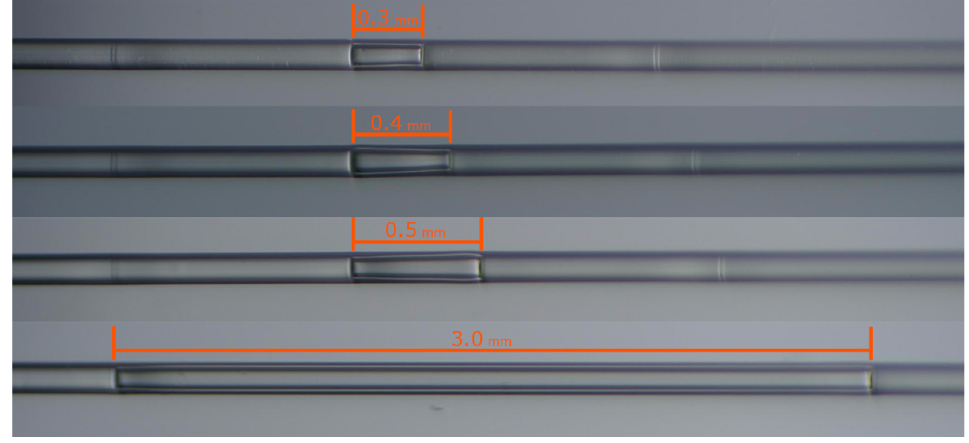
Figure 3. A microscope image of the four MZIs used in this experiment. Table 1. Characteristics of the MZIs.